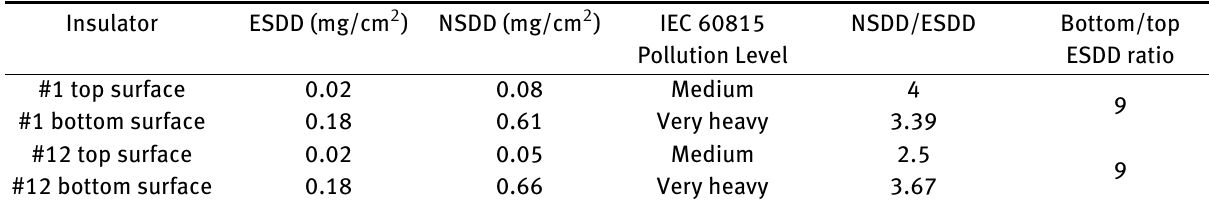
Table 2: DC pollution measurements on RTV-coated